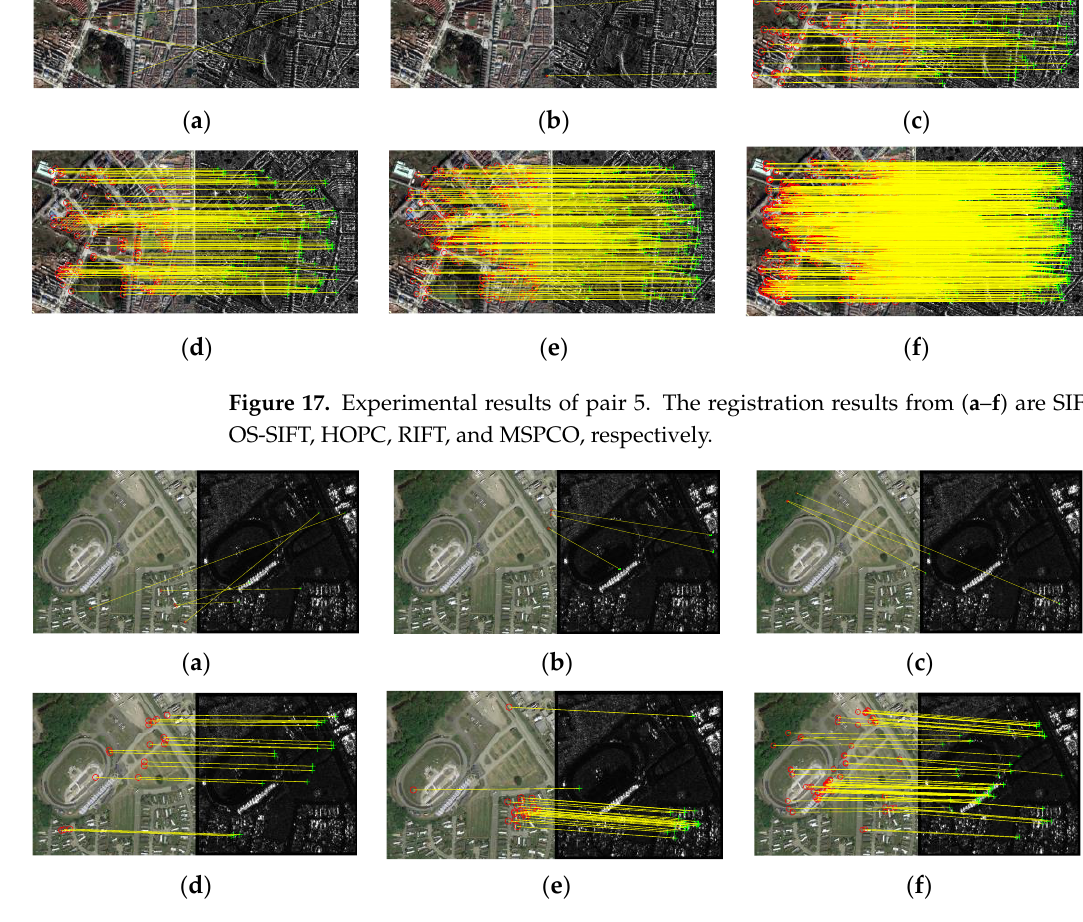
Figure 18. Experimental results of pair 6. The registration results from ( a ) to ( f ) are SIFT, SAR-SIFT, OS-SIFT, HOPC, RIFT, and MSPCO, respectively.